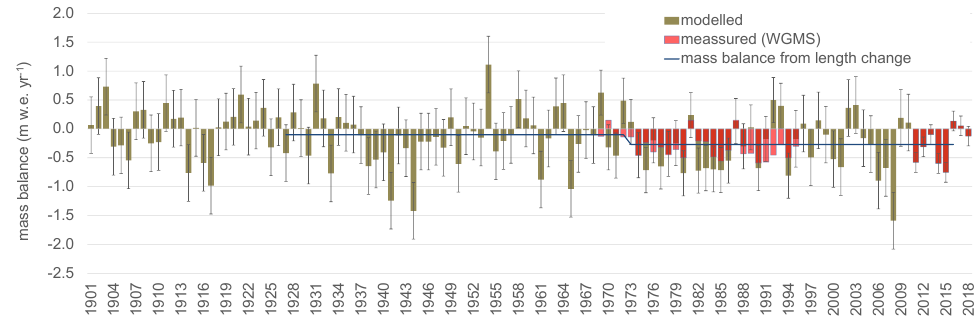
Figure 5. Modeled (green bars) and measured (red bars) mass balance time series with error bars describing the mass balance uncertainty. Blue line showing mass balance change derived from length change observations for two periods (1927 to 1972; 1972 to 2016).